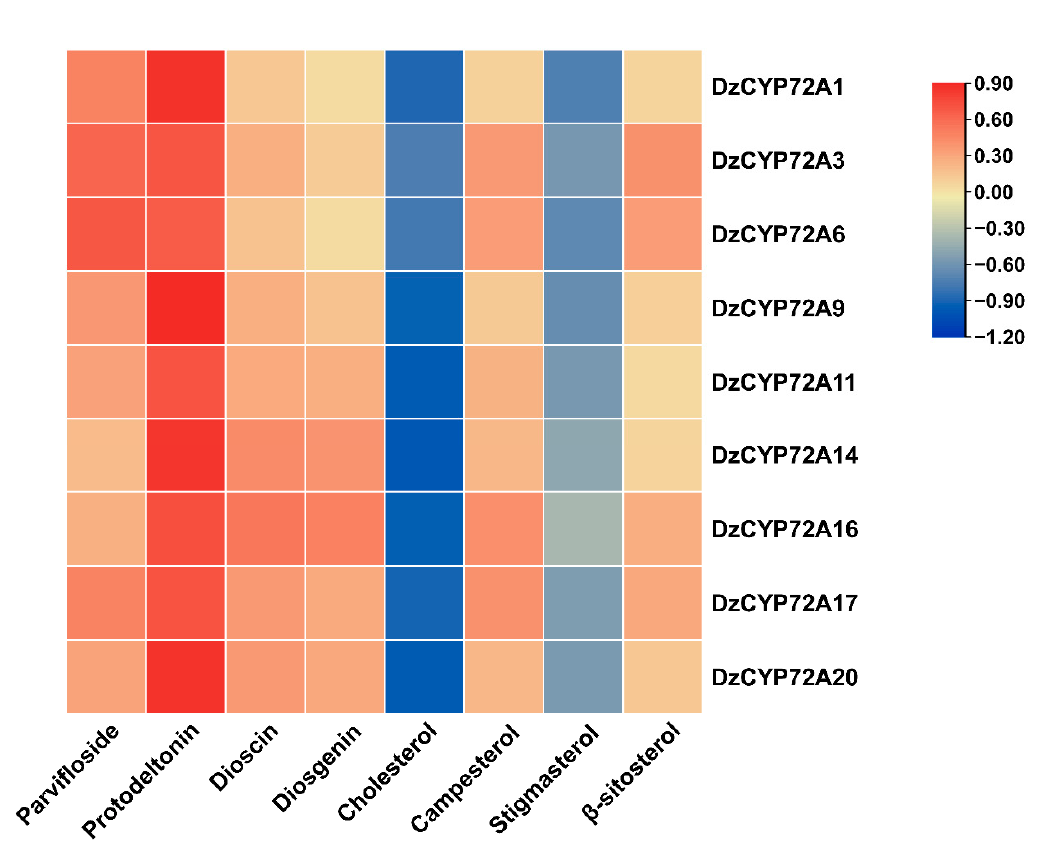
Figure 7. Spearman analysis of correlation between specialized metabolites and DzCYP72As.